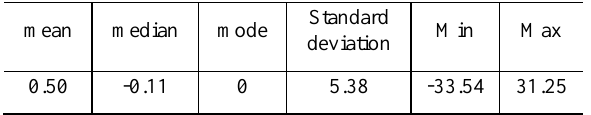
Table 3. PS point difference statistics of overlapping area (mm) The merged cumulative deformation map of Hebei Plain was acquired. A total of 10498468 PS points are shown in Figure 4.